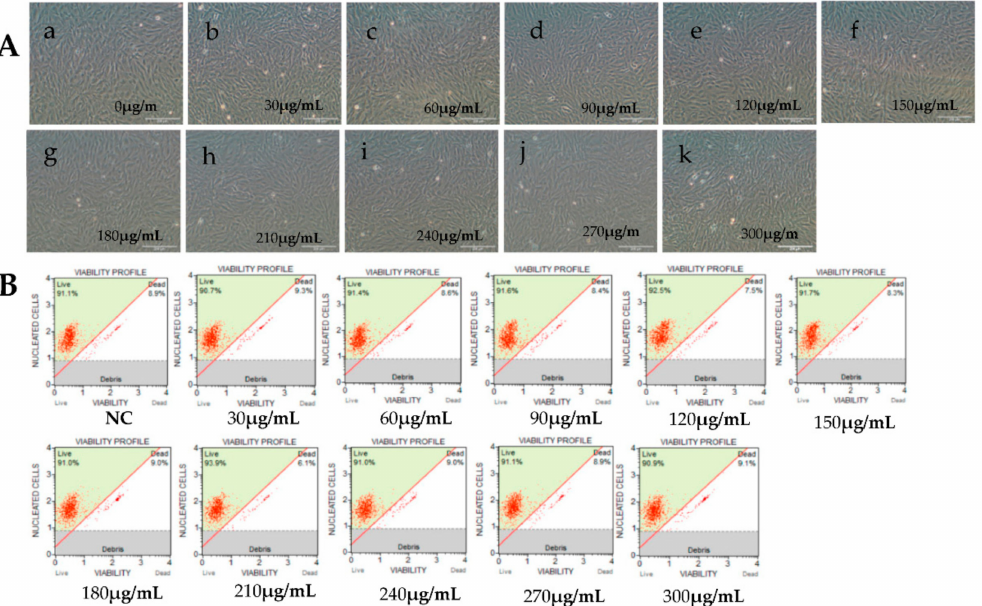
Figure 2. E ff ects of cytarabine injection (Ara-C) at di ff erent concentrations on RyuF-2 cell viability. Ara-C hinders the action of DNA polymerase and inhibits DNA synthesis. Cell viability was determined under a microscope after 14 h of treatment with the di ff erent concentrations of Ara-C (0~300 µ g / mL). ( A , a–k), images of cell cultures under various Ara-C concentrations. ( B ) Corresponding cell viability